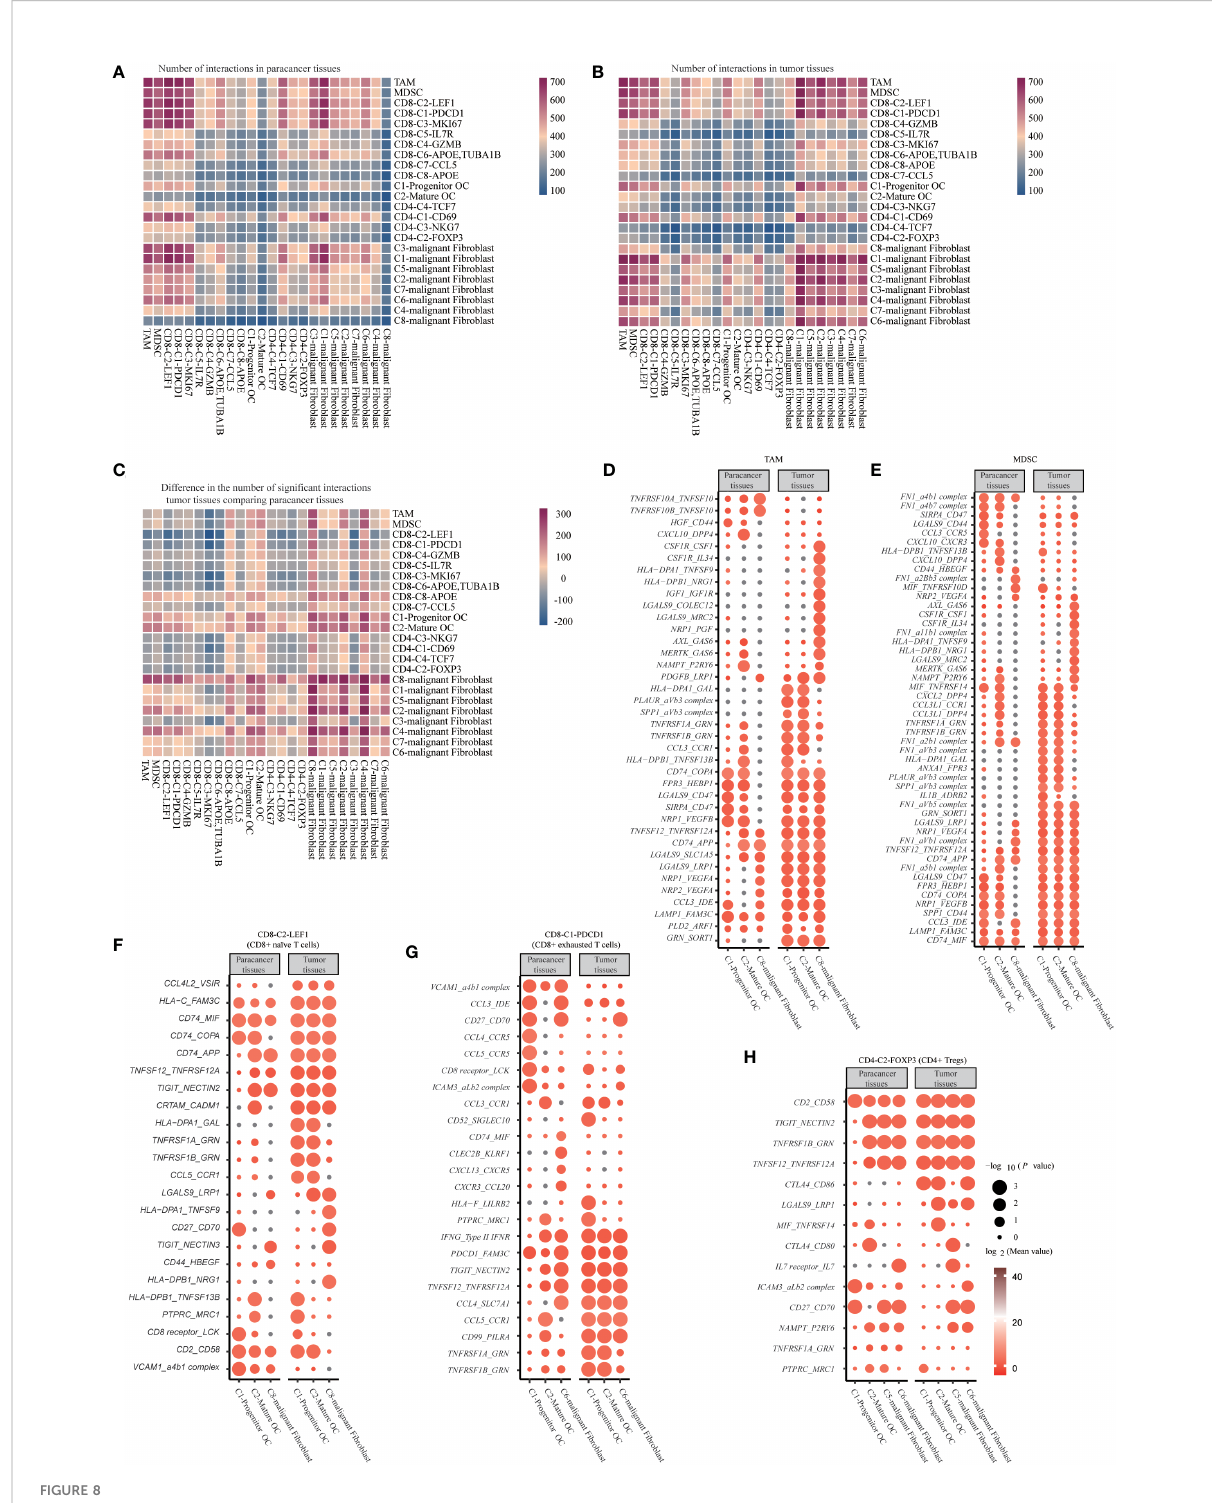
FIGURE 8 Cell Communication Networks in SUPS. (A, B) Heatmap of the number of ligand-receptor pairs each cell has (each row/column represents a cell, and the number of ligand-receptor pairs each cell has is colored, the bluer the cell has fewer ligand-receptor pairs, and the redder the cell has more ligand-receptor pairs). (C) Results of the ratio of the number of ligand-receptor pairs in tumor tissue compared with paracancer tissue. (D-H) Overview of selected ligand-receptor interactions of Macrophages, Osteoclast, Malignant fi broblast cells, and T cells. P values are indicated by circle size, Mean values are indicated by circle